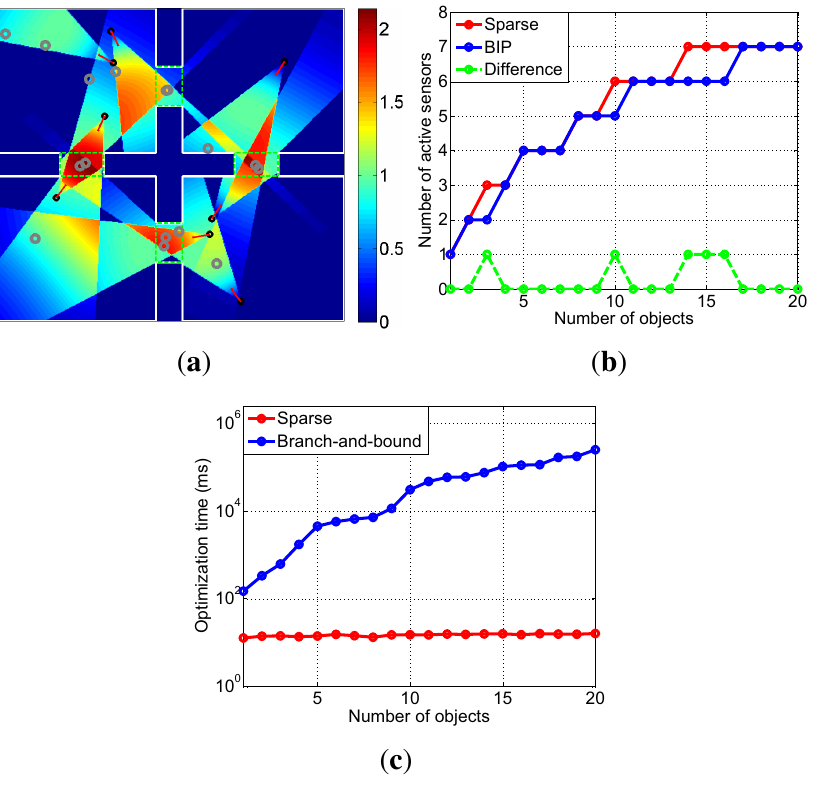
Figure 8. Camera assignment results based on the four rooms scene. (a) Observation effect of camera assignment. The gray rings are the objects. (b) Active camera number obtained by two methods. (c) Optimization time of two